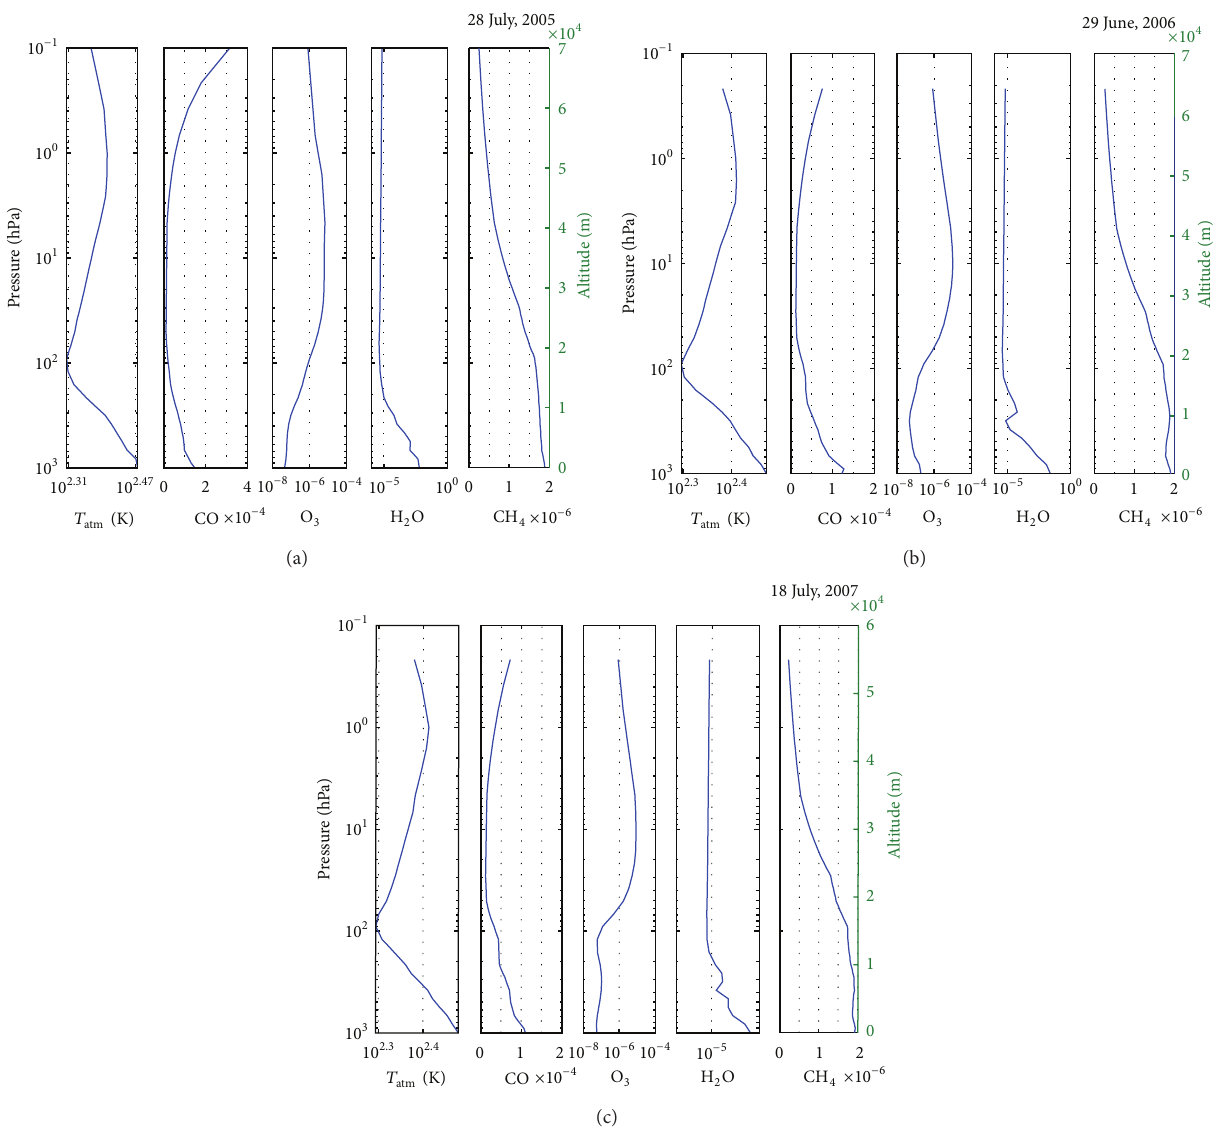
Figure 1: Vertical profiles of TES-derived parameters for selected summer months and days during 2005, 2006, and 2007.